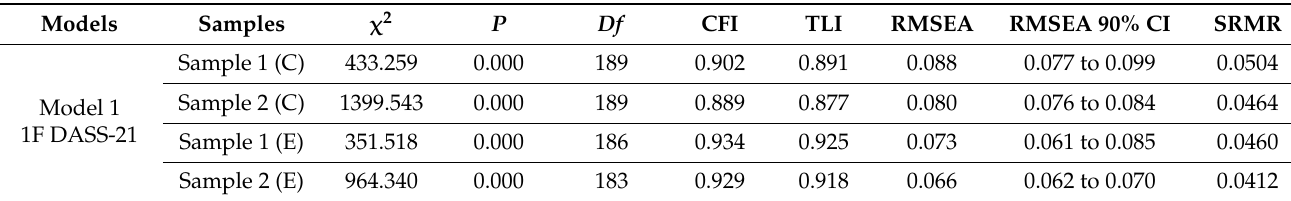
Table 2. Goodness-of-fit indices for different models of the Depression Anxiety Stress Scale 21 (DASS-21) and its shortened versions evaluated by confirmatory factor